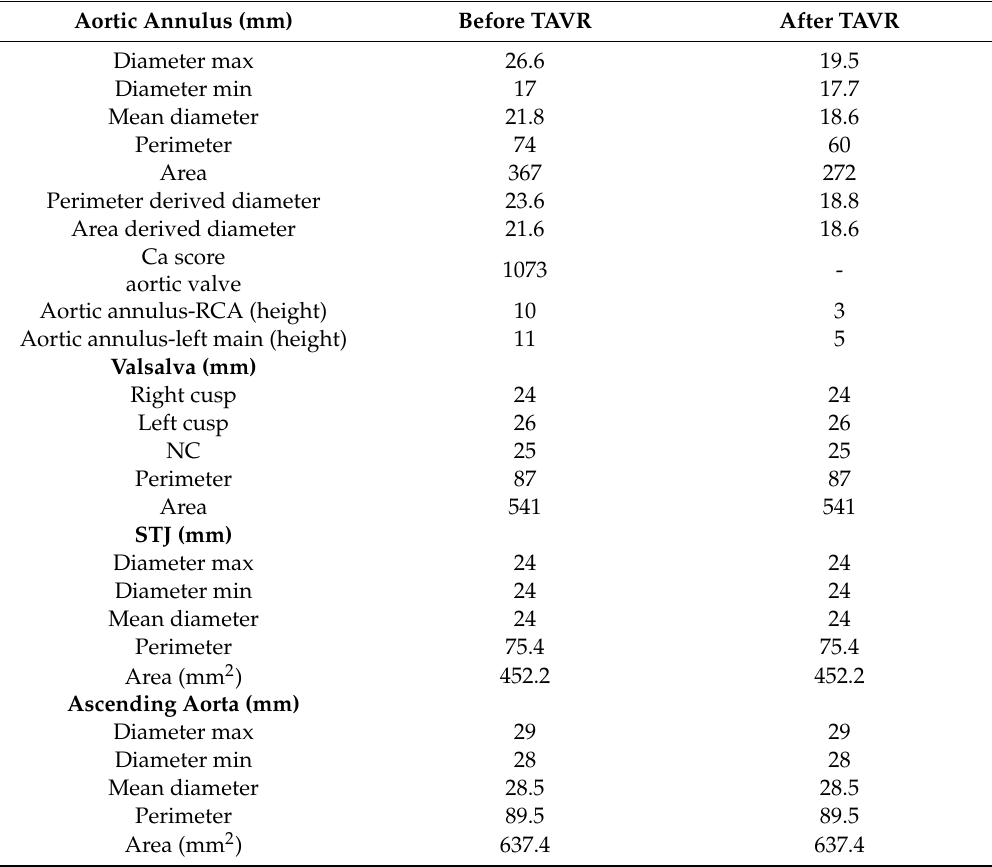
Table 1. Aortic root anatomy and measurements pre and post TAVR. Procedural Gated Computed Tomography (CT). Aortic Root Anatomy Pre and Post